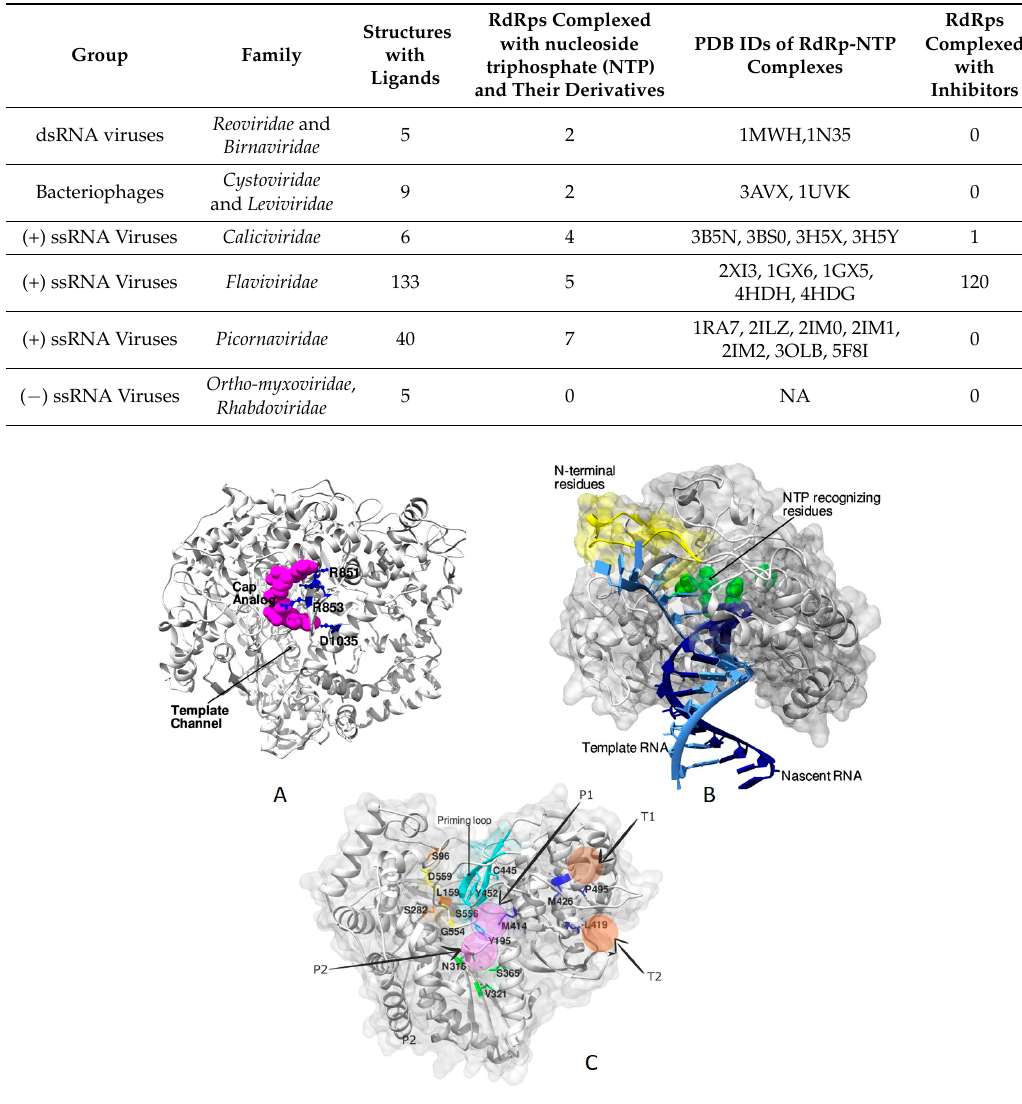
Figure 4. Structures of RdRp complexes of different viruses: ( A ) Figure showing the cap-binding site of MRV3 (PDB ID: 1mwh) [29] on the surface of λ 3 polymerase. The cap-analog is shown as spheres of magenta color, and the interacting residues are depicted in ball-and-stick representation in blue color. The binding of cap helps in distinguishing the (+) RNA from the ( − ) RNA and facilitates transcription [29]. ( B ) The course of entry of template RNA (light blue) and the exit of dsRNA (template and nascent RNA) after polymerization as observed in the PV RdRp (PDB ID: 3ol6) [23]. The residues of the amino terminus (shown in yellow) are demonstrated to have a significant influence on both catalysis and fidelity during RNA synthesis [23]. Residues D233, D238, S288, G289, N297, and D328 that take part in NTP recognition and catalysis are shown as green color spheres. ( C ) Potential allosteric sites are seen in the HCV RdRp associated with the thumb and the palm subdomains. The four sites are depicted as transparent spheres in the figure; two each belonging to the thumb and the palm subdomains. The residues involved in conferring resistance to nucleoside analogs (yellow) and other NNIs are indicated in stick representation. The priming loop is colored in cyan.